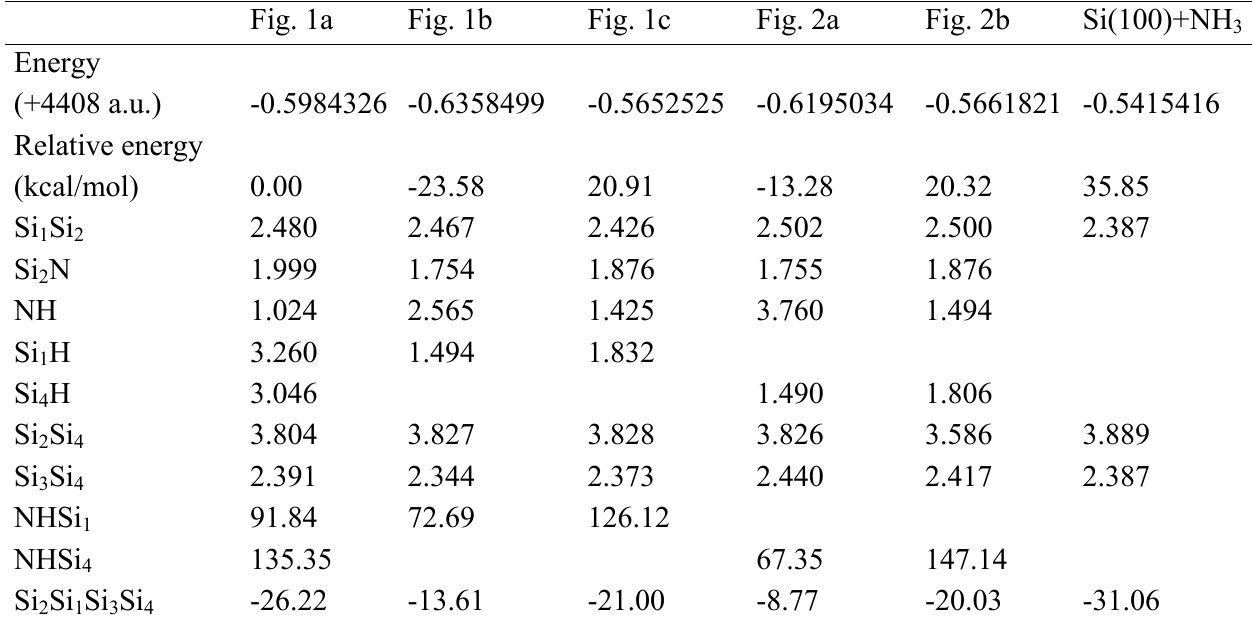
Table 1. Geometrical parameters (Å and degrees) and energies of the clusters presented in Figs. 1 and